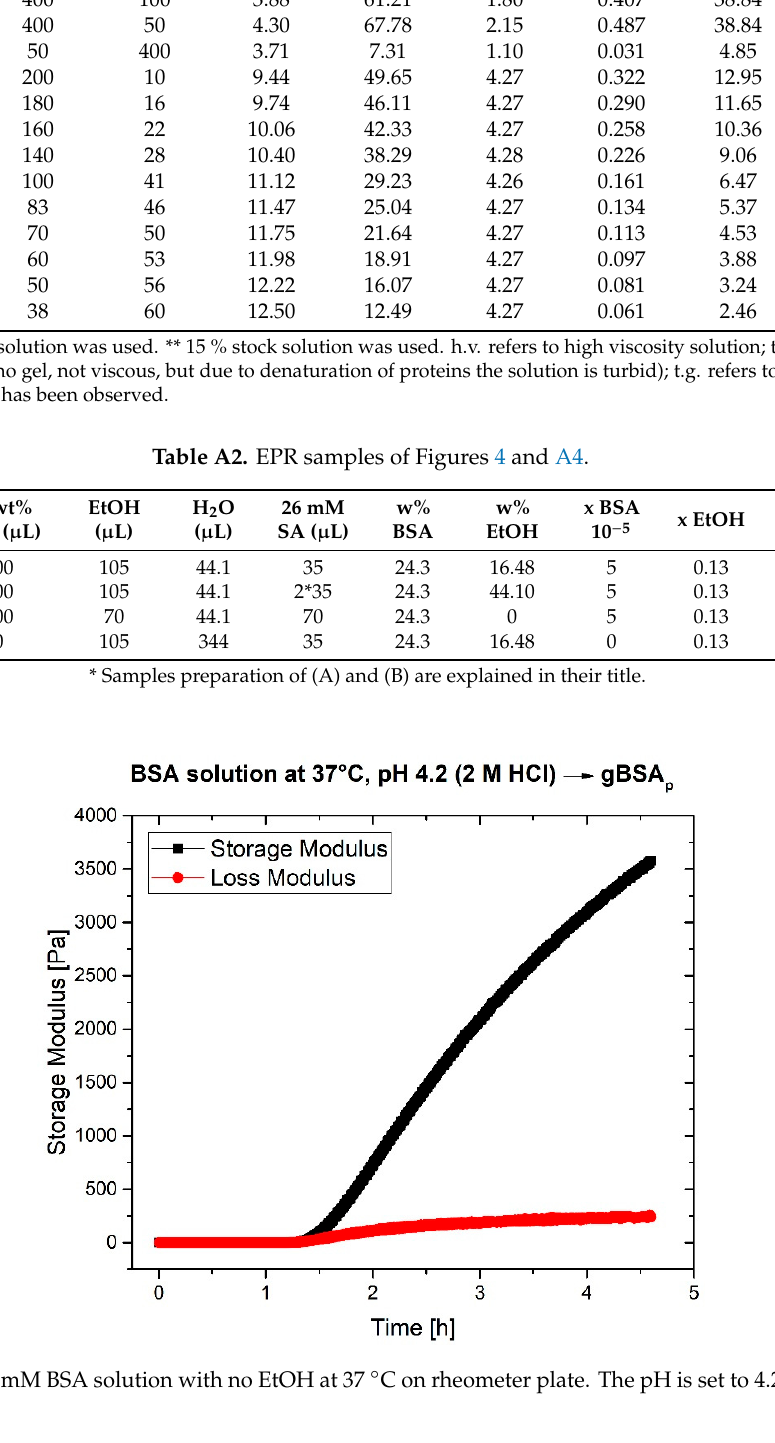
Figure A2. Addition of stearic acid (SA) into the precursor solution of the gels (2.1 mM BSA solution) leads to weakening the mechanical properties of the gels. The SA were dissolved in 0.1 M KOH prior to addition into precursor solution.